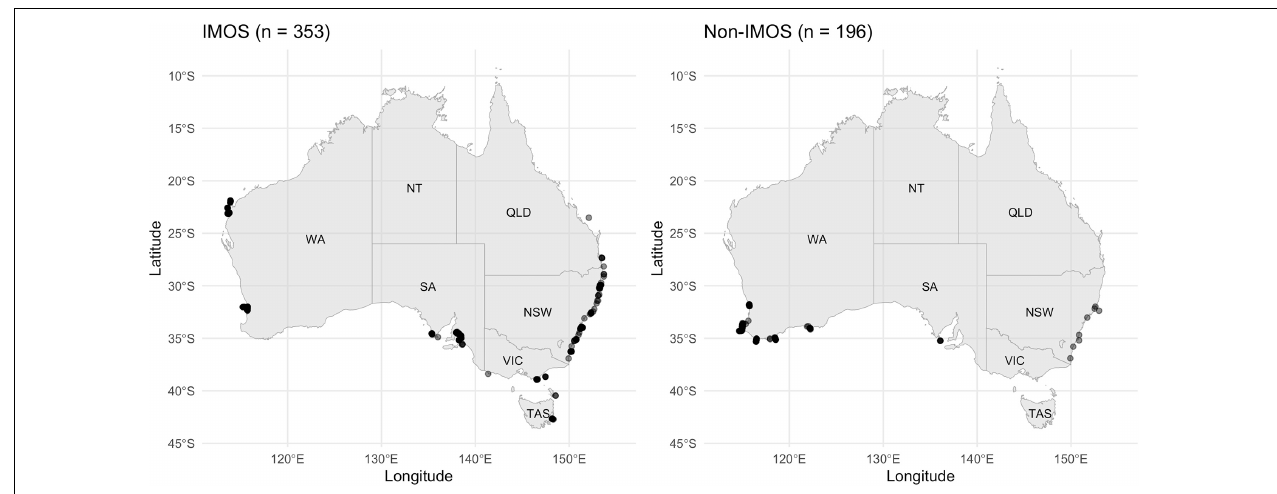
FIGURE 1 | Map of Australia showing the location of (left) Integrated Marine Observing System (IMOS) receivers and (right) non-IMOS receivers that detected bronze whalers and dusky sharks during the study period.